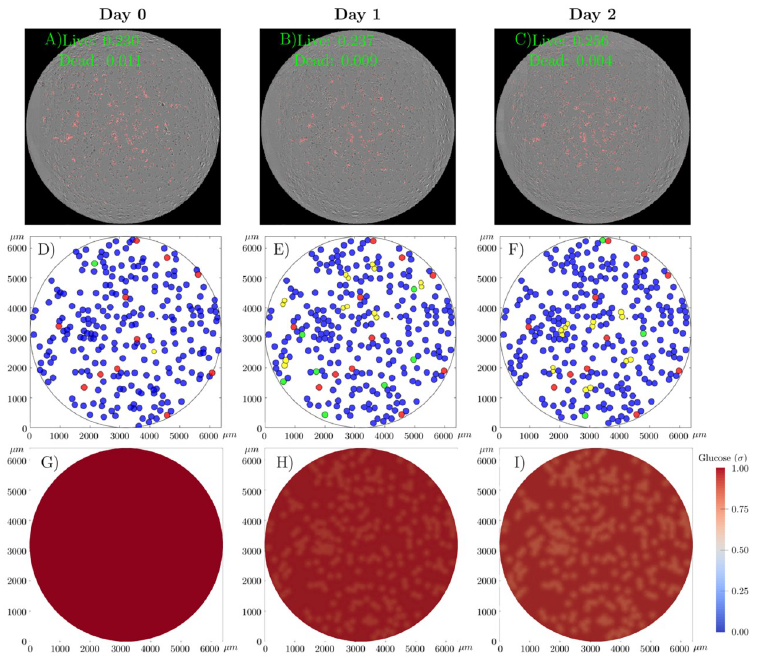
Fig 11. cgABM simulation for the scenario 10-L. Snapshots of one realization of the cgABM simulation for the scenario with low initial tumor cell confluence and 10 mM initial glucose (10-L). The whole-well images from three days of data (panels A, B, and C) show the merged images of phase contrast images and fluorescent images where dead cells were labeled in red by the Cytotox Red. The data present here is one of the four replicates of this scenario. In panels A, B, and C, the confluence of live and dead cells is presented. Spatial-temporal simulations of tumor cells (panels D, E, and F) and glucose concentration (G, H, and I) over three days. Panels A, D, and G display the initial conditions, while panels B, E, and H present the data and model at day 1, and panels C, F, and I display the data and model at day 2. The numerical simulation was performed using the MAP points of the calibrated parameters from the 10-L scenario ( � a MAP ¼ 7 : 31 � 10 (cid:0) 3 h (cid:0) 1 , � a MAP ¼ 1 : 73 � 10 (cid:0) 4 h (cid:0) 1 , λ MAP = 3.44 × 10 − 3 h − 1 , g MAP ¼ 8 : 45 � 10 (cid:0) 3 h (cid:0) 1 , P D D and s MAP ¼ 1 : 94 � 10 (cid:0) 1 ). In panels D, E, and F, the quiescent tumor cells are blue, dead cells are red, proliferative cells H are green, and the daughter cells are in yellow. The low tumor cell confluence does not reduce the glucose to values below σ . Thus, the number of dead cells does not increase due to the lack of glucose. The average error of the live and H dead cells are 3.68 ± 0.52 and 1.84 ± 0.20,